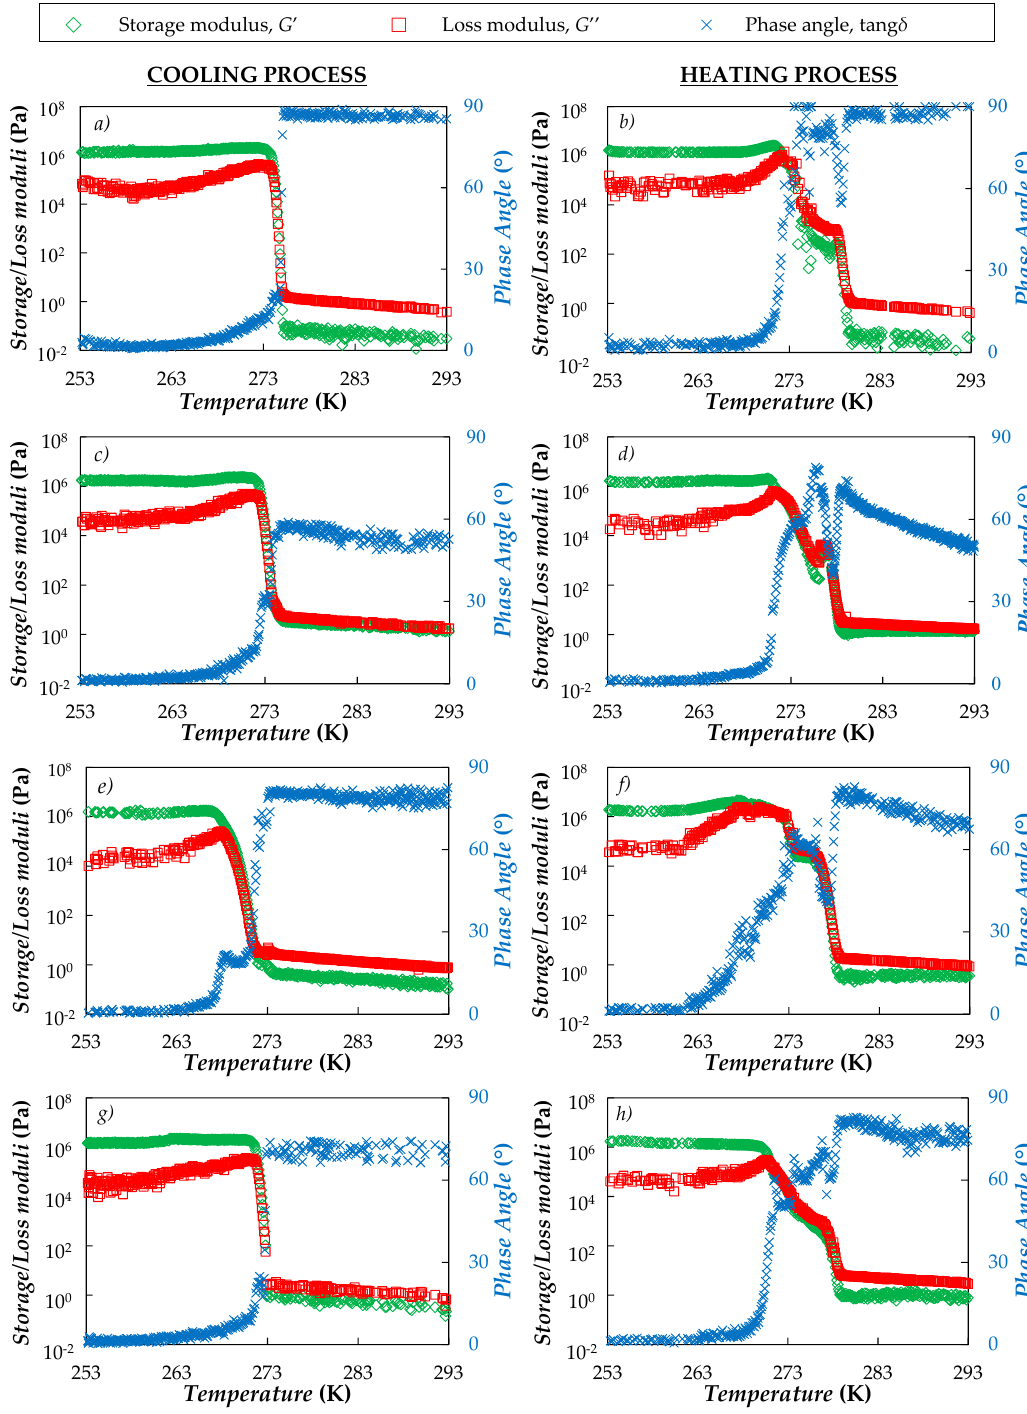
Figure 4. Temperature evolution of ( ) storage modulus, ( (cid:3) ) loss modulus and ( × ) loss phase angle obtained during ( a , c , e , g ) cooling and ( b , d , f , h ) heating processes at 0.5 K·min − 1 for ( a , b ) neat PEG400, ( c , d ) CB(1 wt.%)/PEG400, ( e , f ) nD87(1 wt.%)/PEG400 and ( g , h ) G/D-p(1 wt.%)/PEG400. Test strain and frequency were kept constant at 0.05% and 1 Hz, respectively.